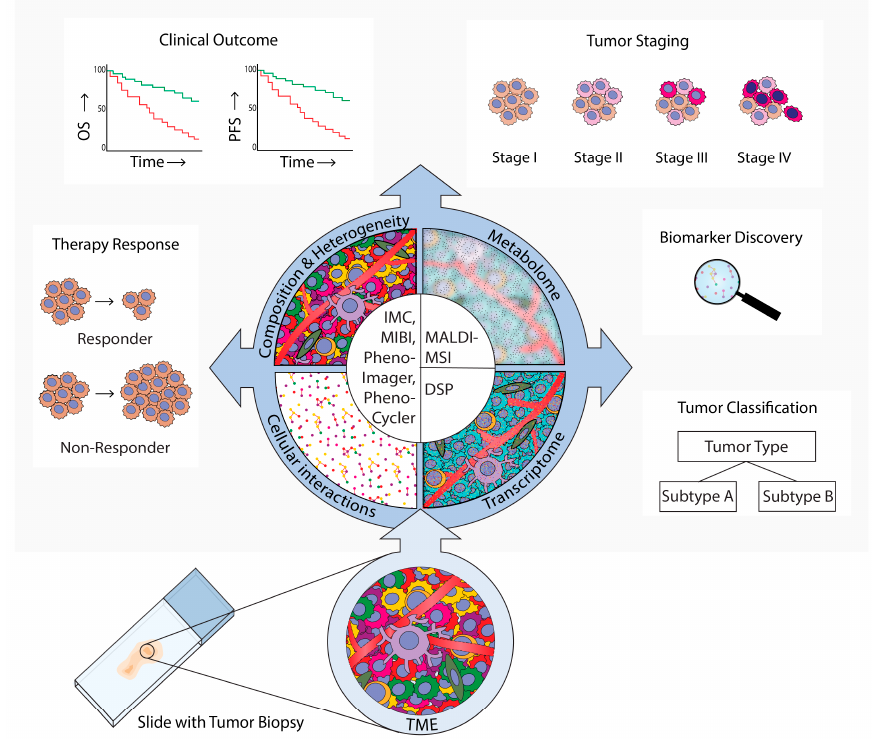
Figure 1. Spatial analysis of the tumor microenvironment (TME). Methods, results, and implications in cancer research. This review provides an overview of technologies that are used for TME spatial analyses in cancer research. These technologies employ microscopy (PhenoImager, PhenoCycler), mass-spectrometry (imaging mass cytometry (IMC)), multiplexed ion beam imaging by